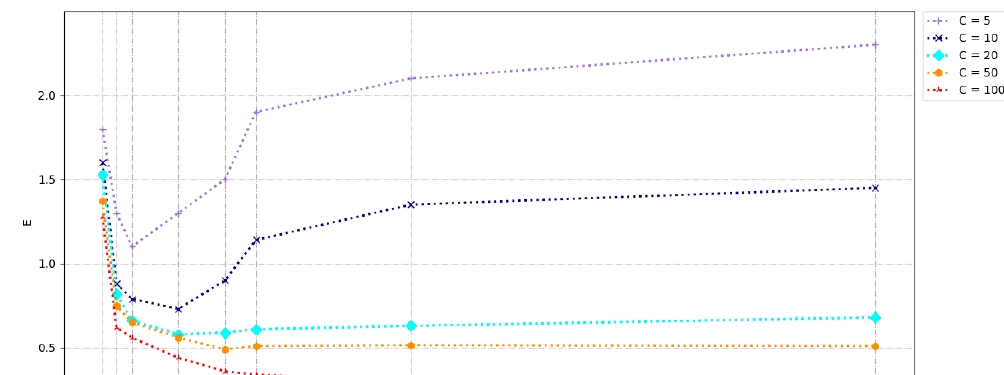
Figure 4. Figure 4.